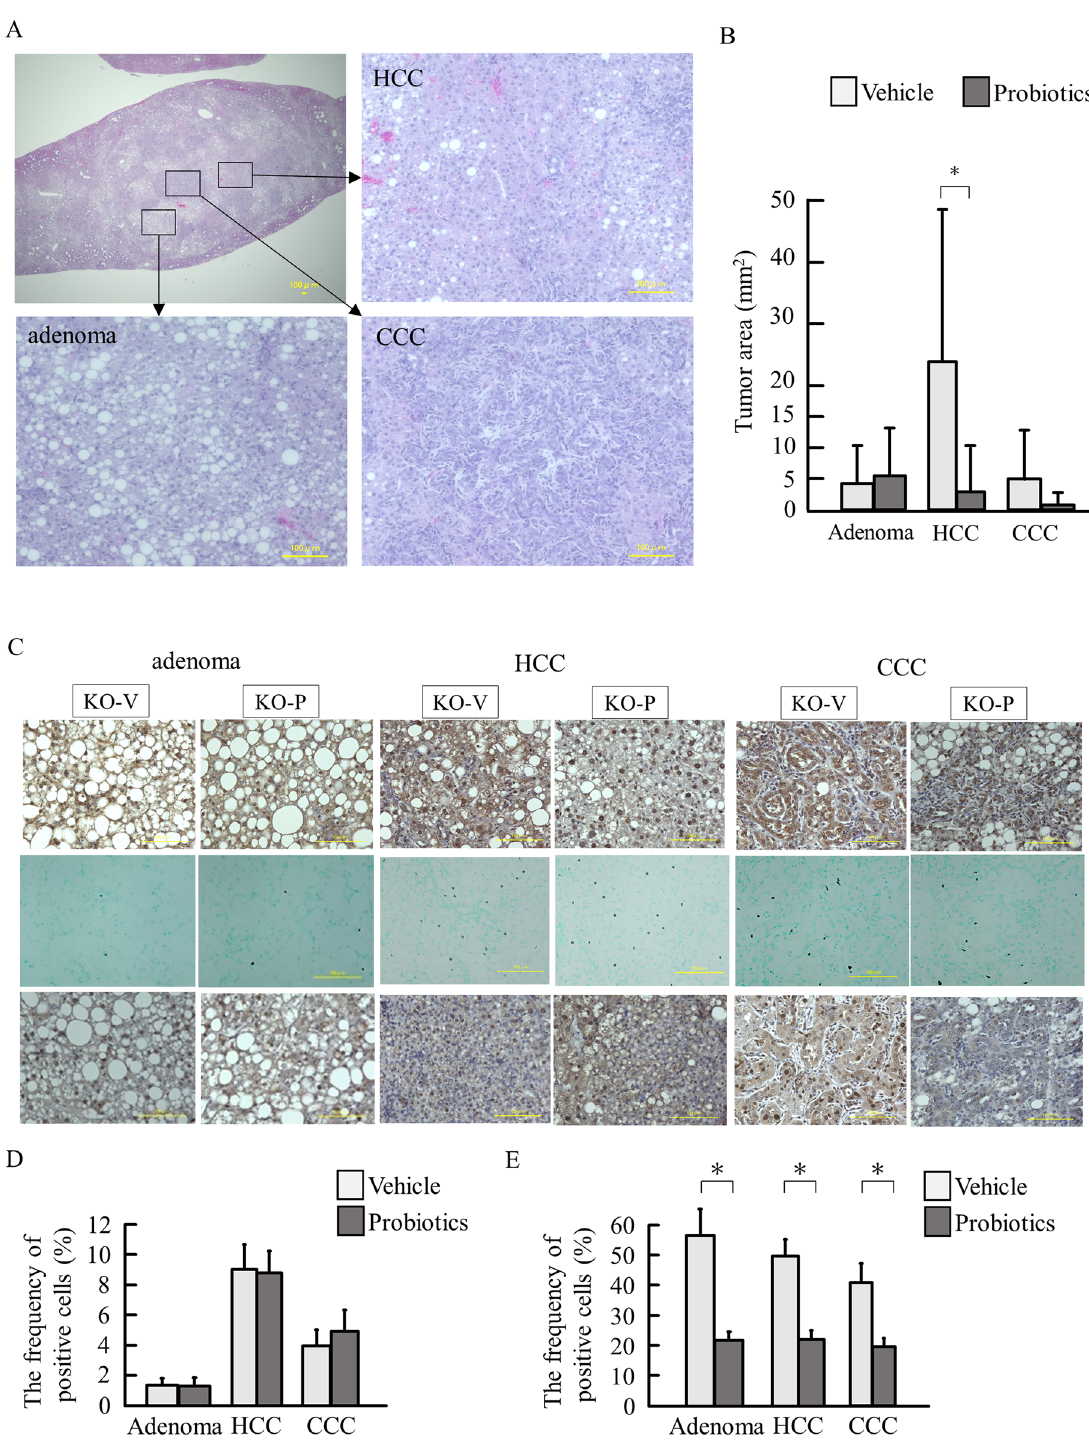
Figure 6. Histological assessment of tumors. ( A ) The representative HE staining of the liver tumor developed in PTEN KO mice. ( B ) The areas of each tumor, including adenoma, HCC, and CCC. ( C ) Staining for 8OHdG (upper), TUNEL (middle), and PCNA (lower). ( D ) The frequency of TUNEL-positive cells. ( E ) The frequency of PCNA-positive cells Groups were analyzed using one-way analysis of variance and the Tukey post-hoc test. Data were presented as mean ± standard deviation. * P <